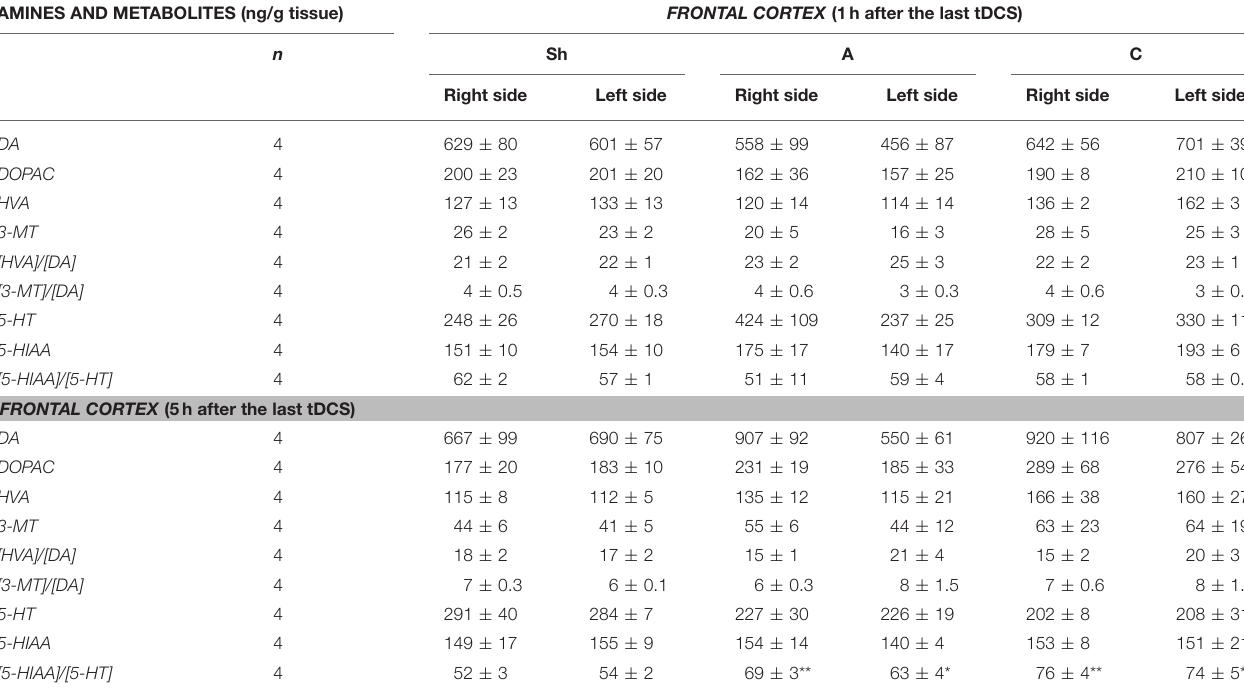
TABLE 4 | The effect of repetitive anodal (A) and cathodal (C) tDCS on the brain concentration of monoamines (DA and 5-HT), their metabolites and on the rate of metabolism at different time point after the last stimulation investigated in the right and left FRONTAL CORTEX. AMINES AND METABOLITES (ng/g tissue) FRONTAL CORTEX (1h after the last tDCS) n Sh A C Right side Left side Right side Left side Right side Left